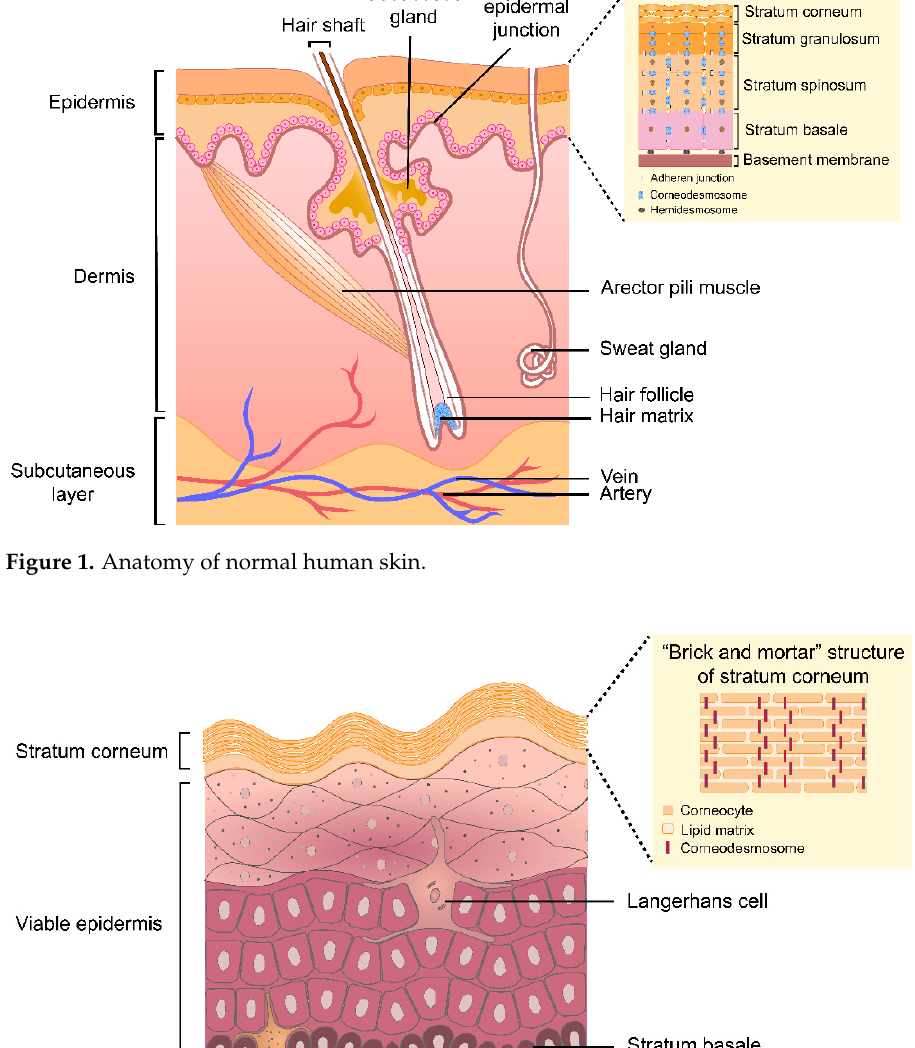
Figure 1. Anatomy of normal human skin.